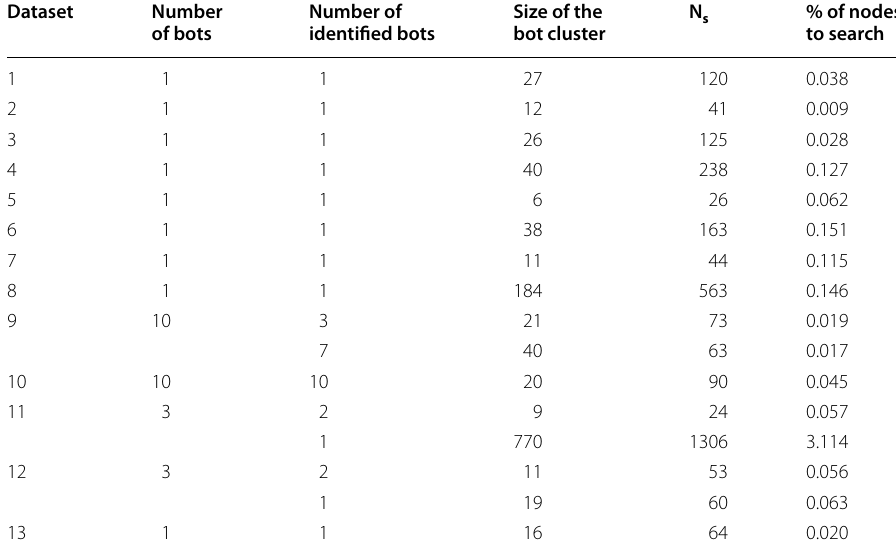
Table 4 Number of nodes to search for bot identification ( N